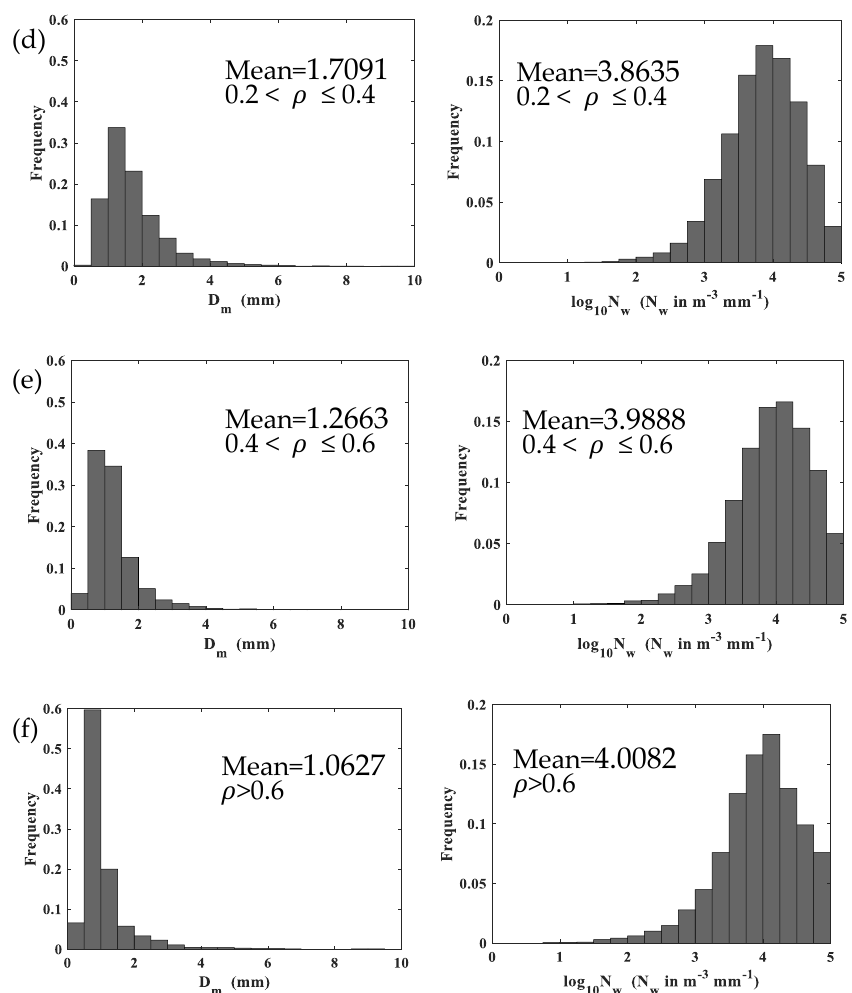
Figure 6. Histograms of D m and log 10 N w for di ff erent density classes: ( a ) 0 < ρ ≤ 0.05 g cm − 3 , ( b ) 0.05 < ρ ≤ 0.1 g cm − 3 , ( c ) 0.1 < ρ ≤ 0.2 g cm − 3 , ( d ) 0.2 < ρ ≤ 0.4 g cm − 3 , ( e ) 0.4 < ρ ≤ 0.6 g cm − 3 , ( f ) ρ > 0.6 g cm − 3 . Table 3. Mean values of D m , log 10 N w , and µ for di ff erent density classes.